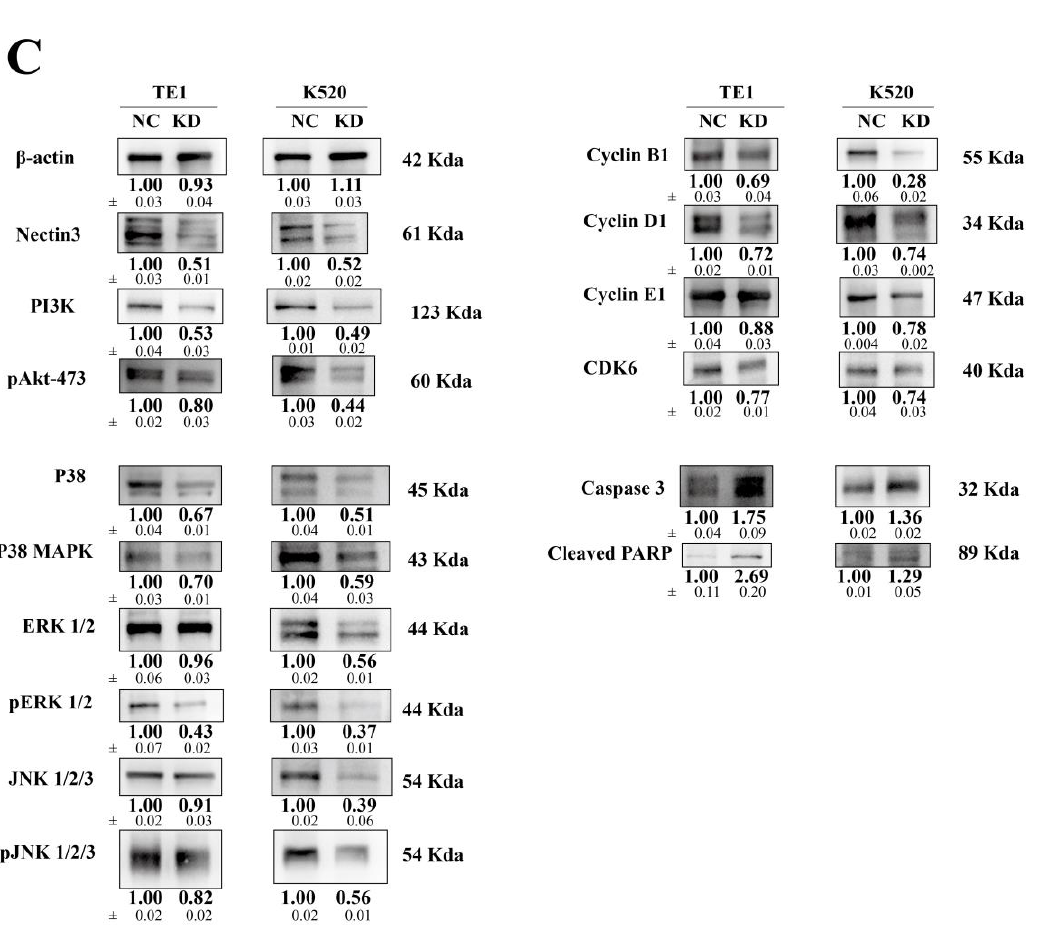
Figure 9. Downregulation of Nectin3 expression phenocopies the profile of CD155 knockdown. ( A ) Nectin3 expression and the correlation analysis between CD155 and Nectin3 expression were predicted using the GEPIA database and ( B ) validated at the protein level through tissue microarray. ( C ) Nectin3 is knocked down using siRNA. Changes similar to those of CD155 knockdown were seen in TE1 and K520 cells. * p < 0.05; **** p < 0.0001. The original WB Blots of subfigure ( C ) are Figure S9.